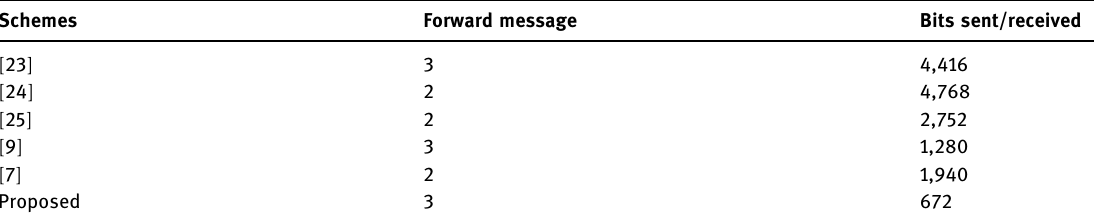
Table 6: Comparison of communication bits with existing protocols Schemes